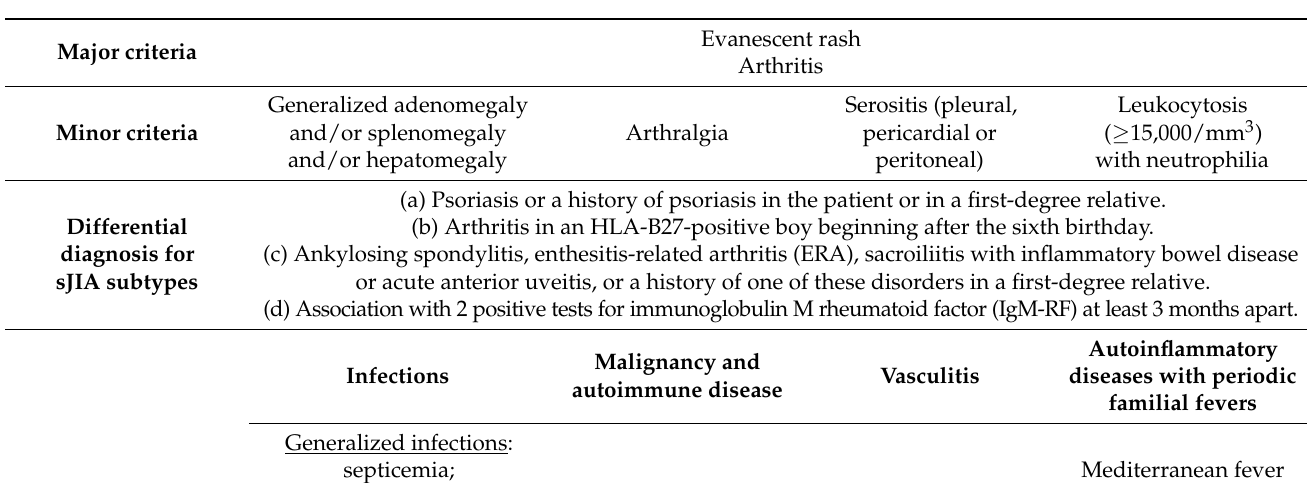
Table 2. Positive and differential diagnosis for sJIA. Fever of unknown origin prolonged, daily, in bursts of ≥ 39 ◦ C for a period of at least two weeks plus two major criteria; or one major criterion and two minor